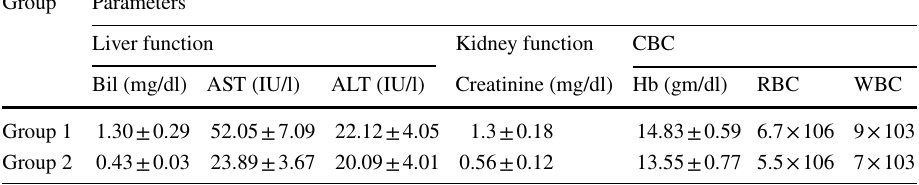
Bil, bilirubin, AST, aspartate transaminase; ALT, alanine transaminase; Hb, hemoglobin; RBC, red blood corpuscles; WBC, white blood corpuscles; CBC, complete